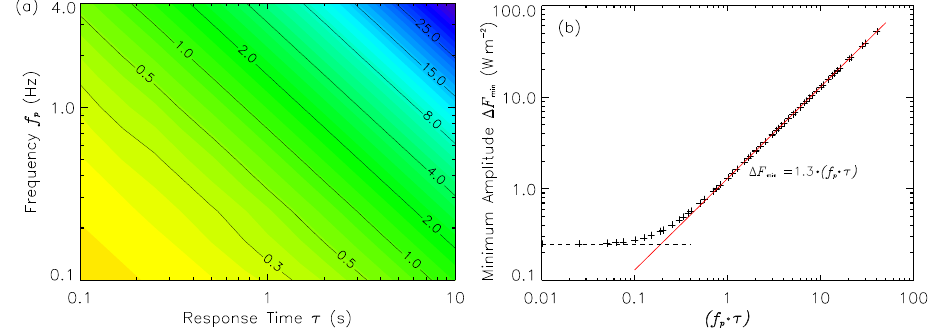
Figure 2. (a) Minimum amplitude (cid:49)F min of fluctuations which theoretically can be resolved by deconvolution in dependence of the sensor response time τ and the oscillation frequency f p . (b) Similar to (a) (cid:49)F min is given as a function of the product (f p · τ) . Symbols illustrate the results of the calculation. The red line indicates a linear fit for large (f p · τ)